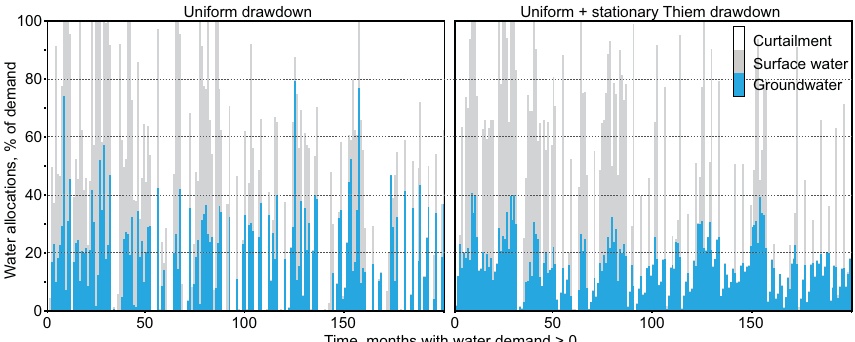
Figure 8. Composition of allocations and curtailments to wheat agriculture in the Hebei province for the months March, April, May, and June through 51-year simulation from an initial groundwater storage at equilibrium (258km 3 ) . The results are shown for a simple drawdown model with uniform regional lowering of the groundwater table, and a more realistic drawdown model, which includes the stationary Thiem local drawdown cones.